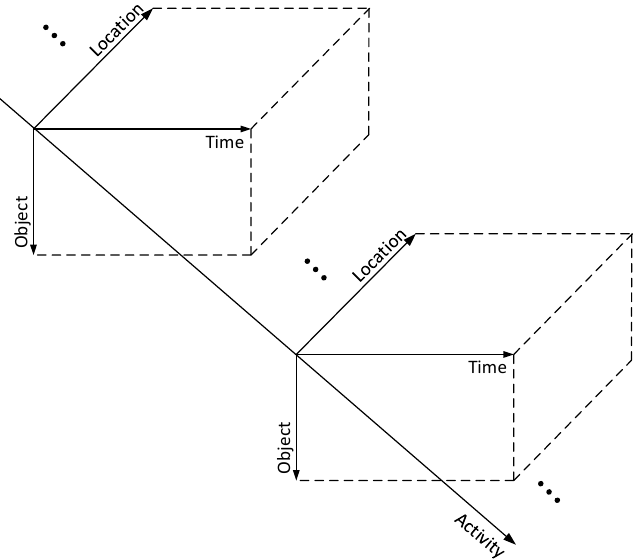
Figure 7. Graphic illustration of the proposed fourth-order tensor model for smart communities.